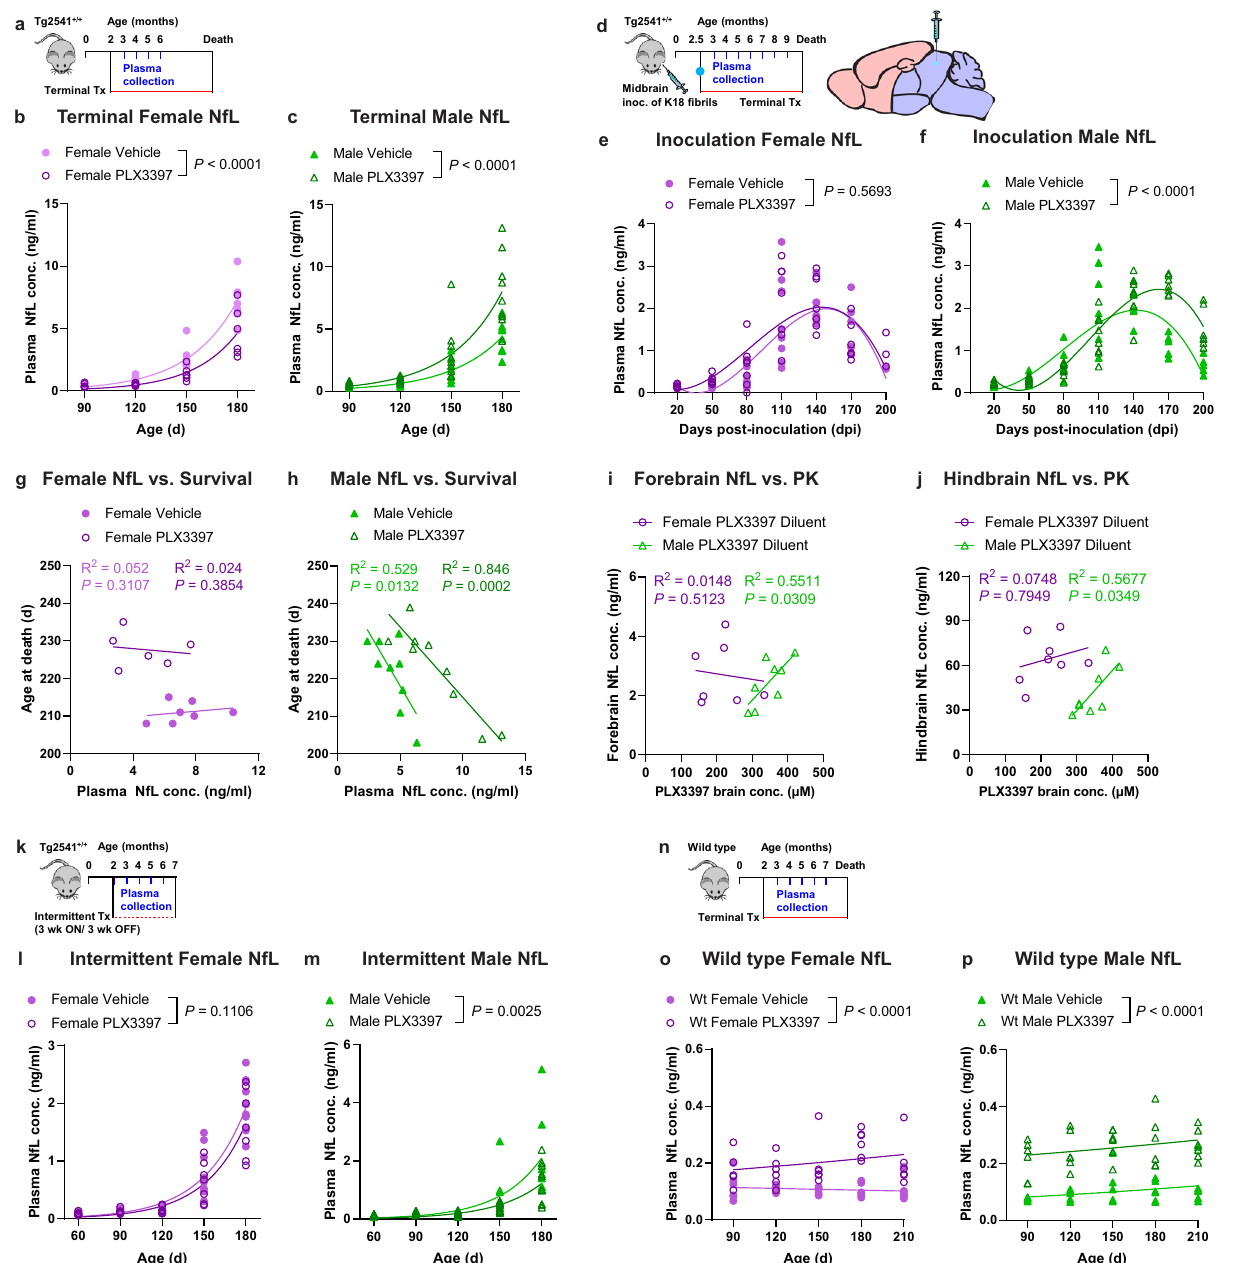
or hindbrain of an individual mouse. In ( g – j ), linear regression and Pearson ’ s cor- relation analyses were performed and the results are shown. k Schematic of intermittentPLXtreatmentofTg2541micefrom2 – 7moofage,withthreeweekson treatmentfollowed bythree weeksoffof treatment, and blood plasmacollected at 2,3,4,5,and6moofage. l , m PlasmaconcentrationofNfLinfemale( l )ormale( m ) Tg2541 mice receiving intermittent treatment with vehicle or PLX3397. Groups were compared by nonlinearregression. n Schematic of terminalPLXtreatment of C57BL/6J wild type mice (Wt) from 2 mo of age until death and blood plasma collectedat3,4,5,6,and7moofage. o , p PlasmaconcentrationofNfLinfemale( o ) or male ( p ) Wt mice treated with vehicle or PLX3397. Groups were compared by nonlinearregression.In( b , c , e , f , l , m , o ,and p ),thedifferencesbetweenvehicleor PLX3397 treatment were evaluated by nonlinear regression using exponential growth models( b , c , l , m , o ,and p )or third-orderpolynomialmodels( e and f )and the best- fi t lines and statistical results are shown. Each symbol represents an indi- vidual mouse. Source data are provided as a Source Data fi